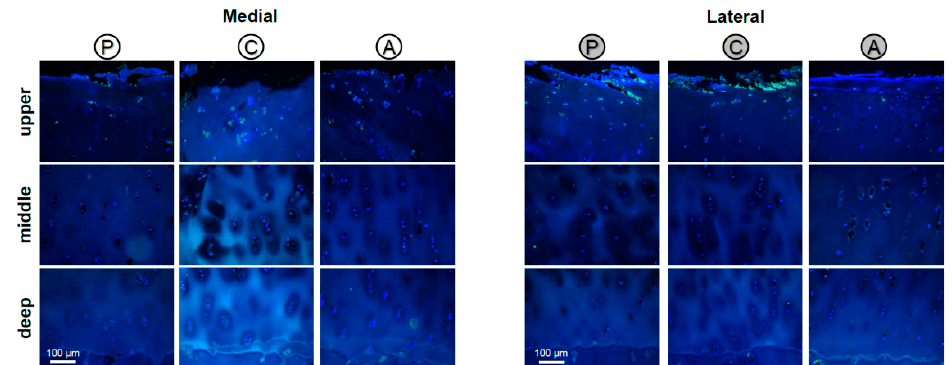
Figure A2. Immunofluorescence staining of STIM1 in chondrocytes on articular cartilage sections. STIM1 could be detected in chondrocytes of the upper, middle and deep cartilage zones from the different cartilage subregions (A: anterior, C: central, P: posterior) of the medial and lateral tibial compartments. The strongest staining was found in chondrocytes of the upper zone. Representative STIM1-stained sections of the different subregions from one patient are shown.